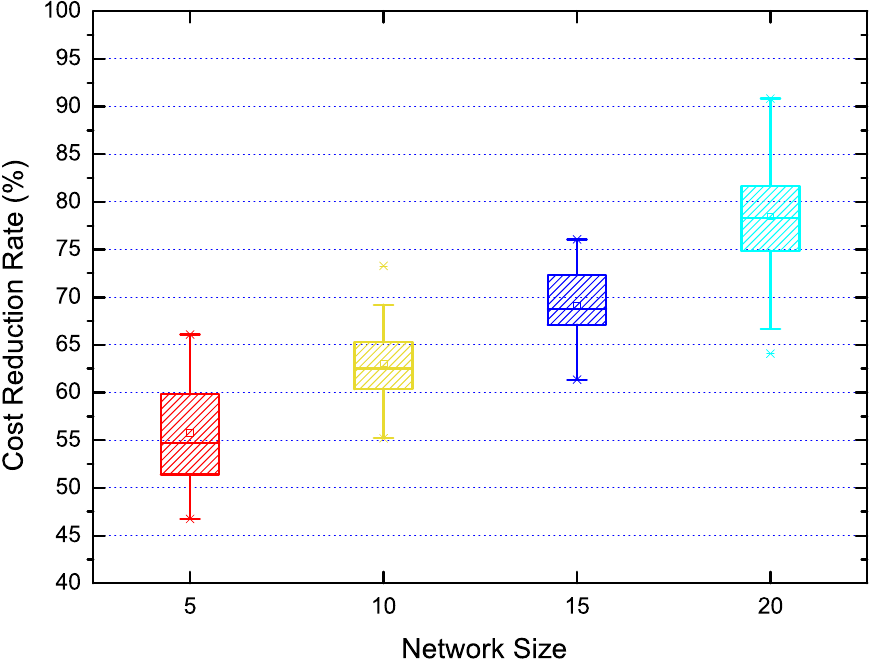
Figure 9. The cost reduction by measurement scheduling under different network size.